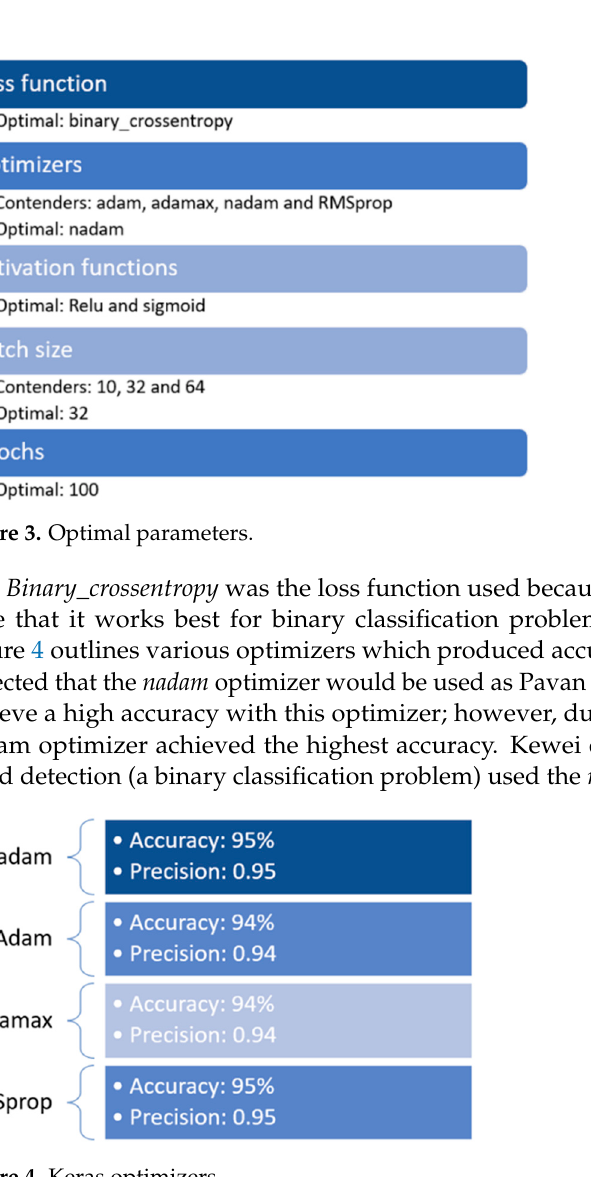
Figure 4. Keras optimizers.